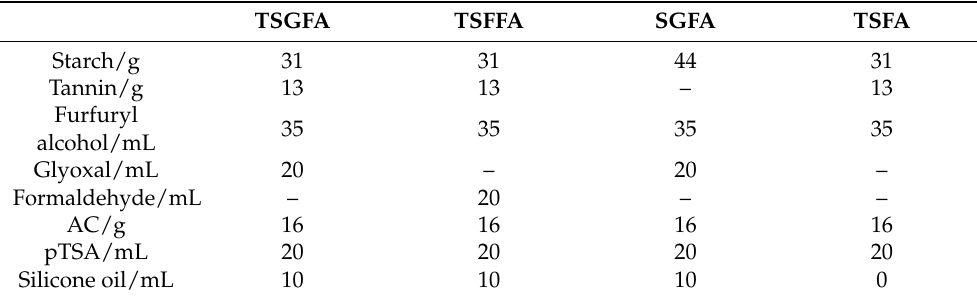
Table 1. Relevant formulations employed for preparation of various foam